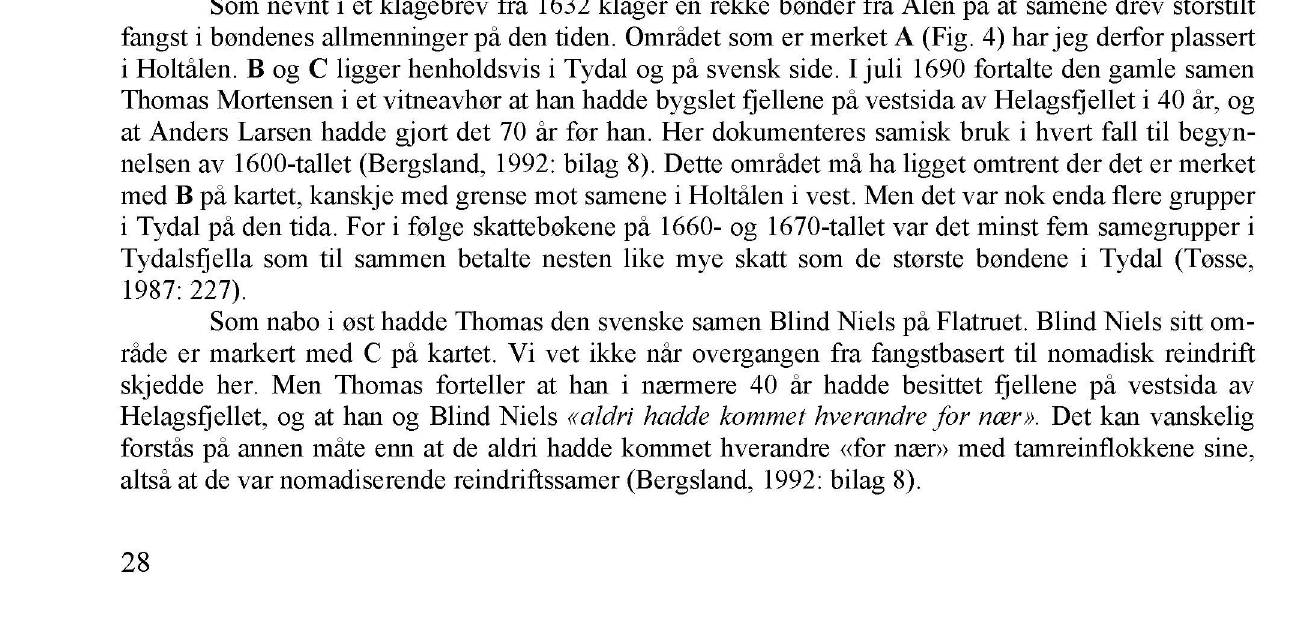
Fig. 4. Sijth (samebyer) som drev fangstbasert og/eller nomadisk reindrift i Rørostraktene på